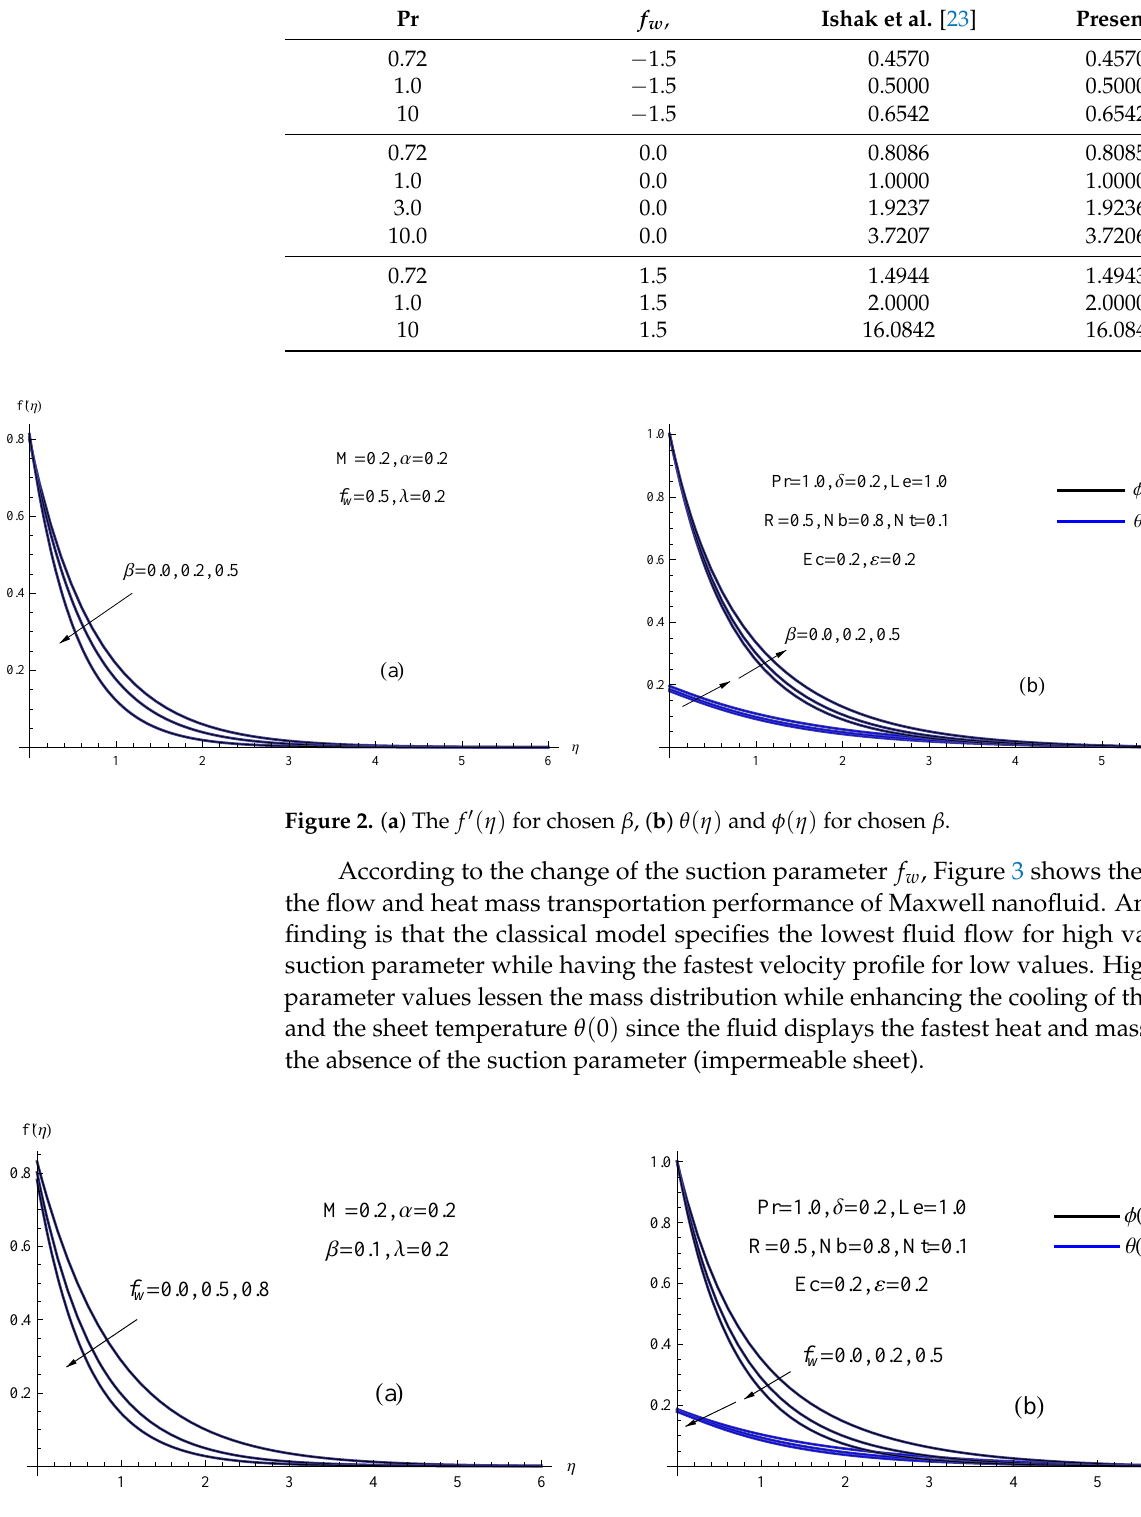
Figure 3. ( a ) The f (cid:48) ( η ) for chosen f w , ( b ) θ ( η ) and φ ( η ) for chosen f w . Figure 4 depicts variations in velocity f (cid:48) ( η ) , temperature θ ( η ) and concentration φ ( η ) caused by the magnetic field’s M impact on the Maxwell nanofluid. Various inputs of